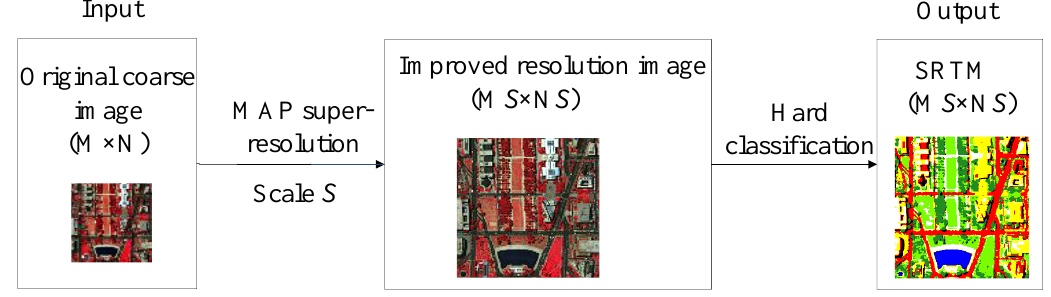
Figure 3. The flowchart of the MTC (MAP super-resolution then hard classification). MAP, maximum a posteriori probability.